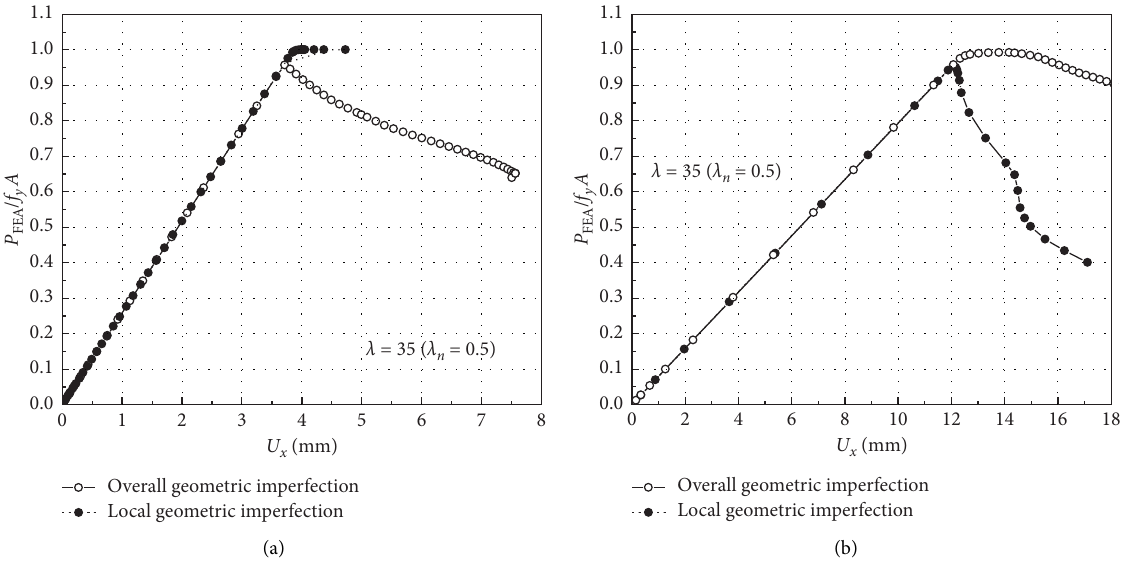
Figure 12: Comparison of load-axial deformation curves considering different geometric imperfections. (a) D159 × 6 ( λ � 35). (b) D508 × 8 ( λ �